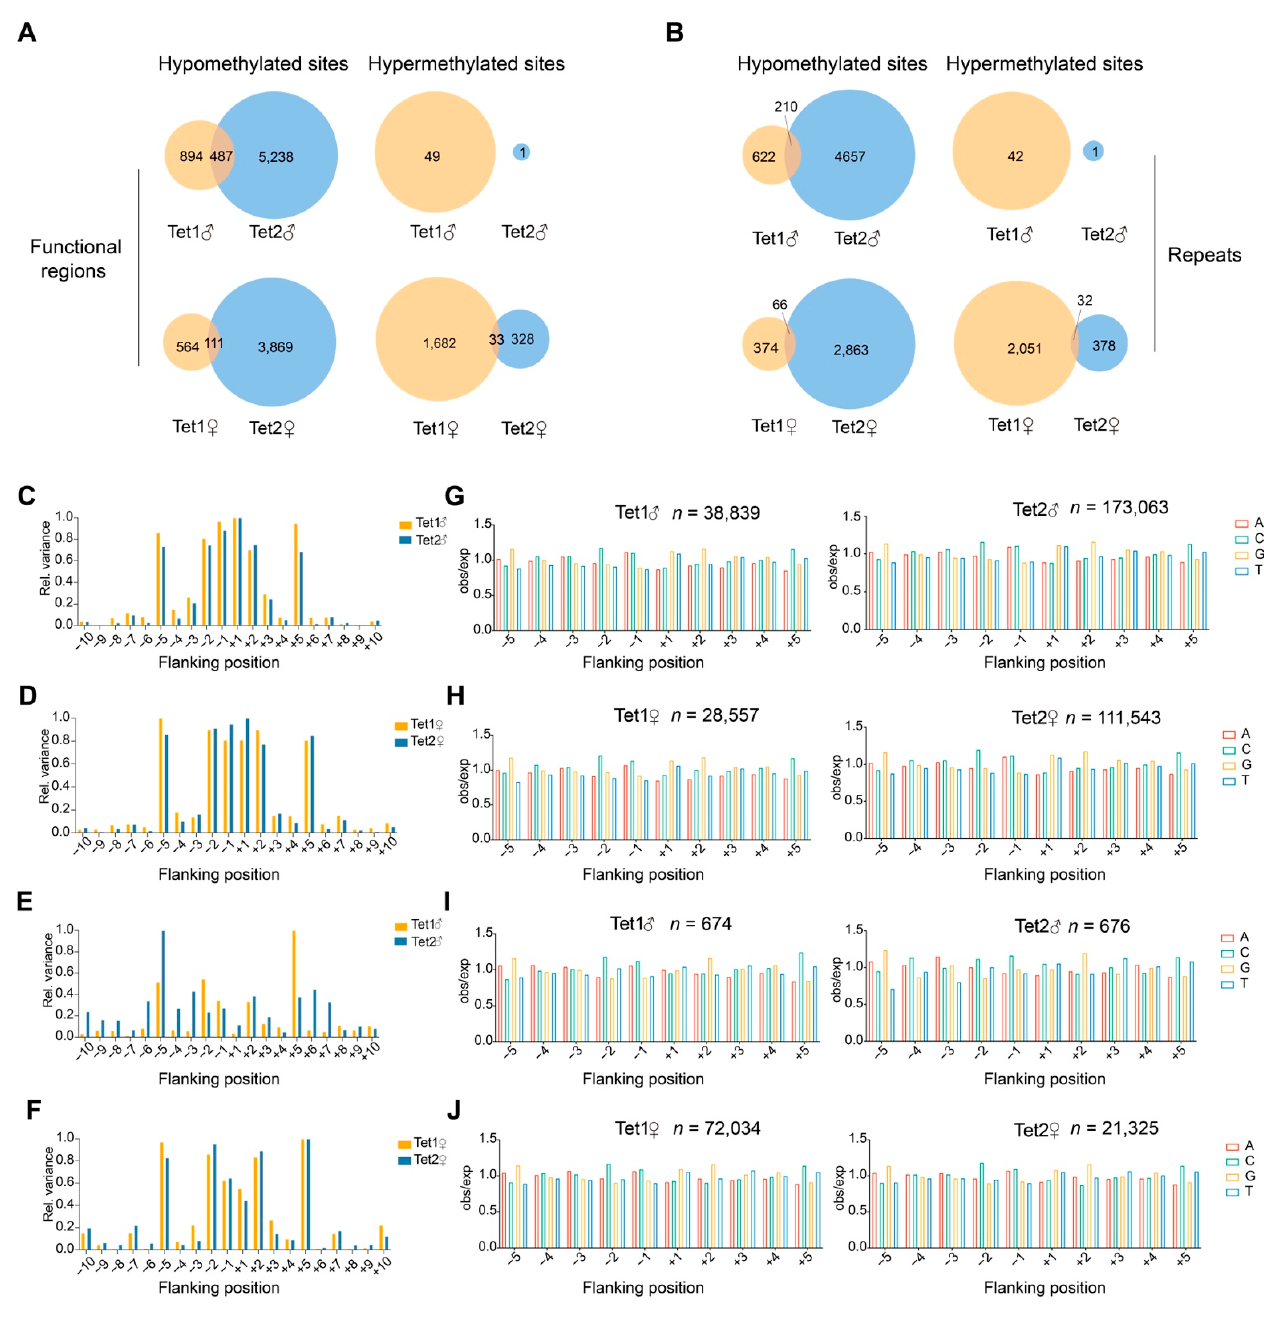
Figure 3. Analysis of Tet1- and Tet2-acted sites. ( A , B ) The numbers of methylation changed-sites from Tet1 and Tet2 injection compared with GFP injection. The DMRs overlapping region ≥ 1 bp and q-value < 0.01 were considered methylation overlapped sites. The term “hypomethylated sites” was defined by more than 20% methylation reduction than the GFP injection control, while “hypermethylated sites” were the opposite. ( C – J ) The propensity of Tet1 and Tet2 to act on sequences flanking CG. The observed/expected (obs/exp) values are presented as the frequency of occurrence of individual bases. The sum of the (obs/exp − 1)2 values of A, C, G, and T at CG positions context ( − 10 to +10), considered relative variation, were examined separately on the parental genome. The analysis of hypomethylated sites ( C , D ) and hypermethylated sites ( E , F ) is shown (hypomethylation and hypermethylation here represent a single CG position situation, FDR < 0.05). ( G – J ) Detailed base frequency for different positions of CG. “n” indicates the numbers of sequences analyzed.